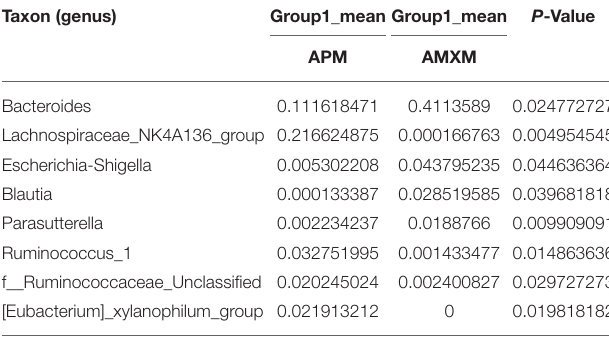
TABLE 5 | Based on Metastats analysis for flora differences between APHL and Con groups under the genus. Taxon (genus)